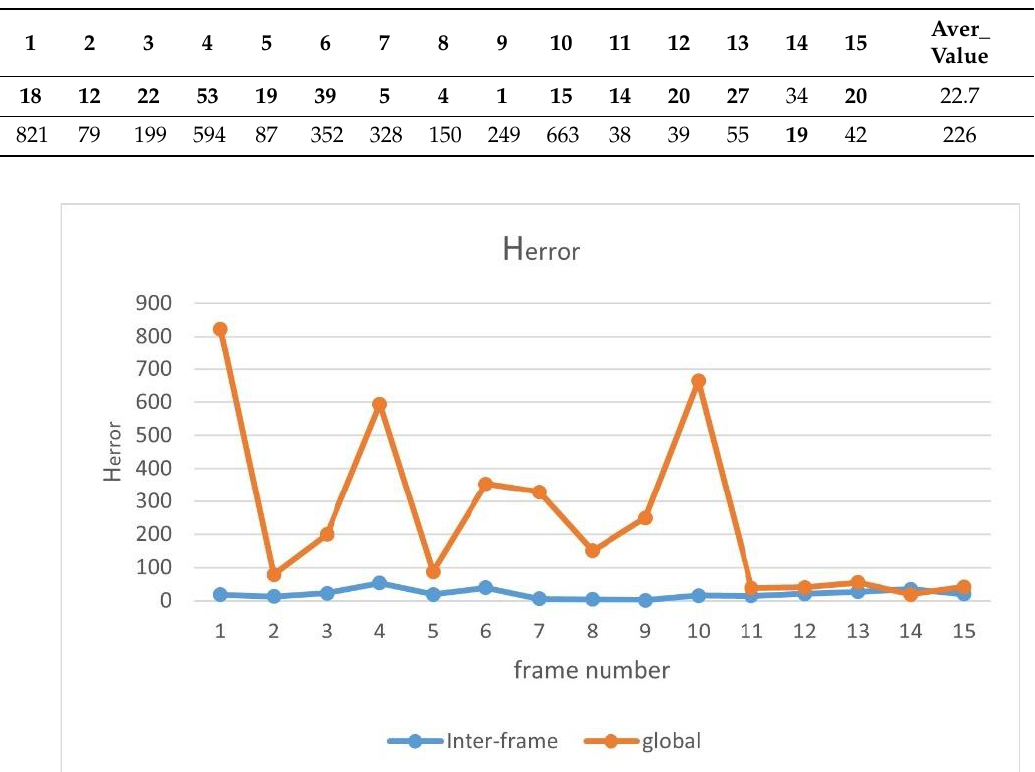
Table 5. Comparison of the inter-frame and global H error values. The better results are highlighted in bold.